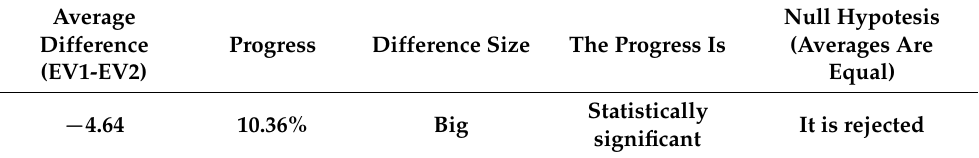
Table 11. Table of average differences of percentage weight distribution on the right